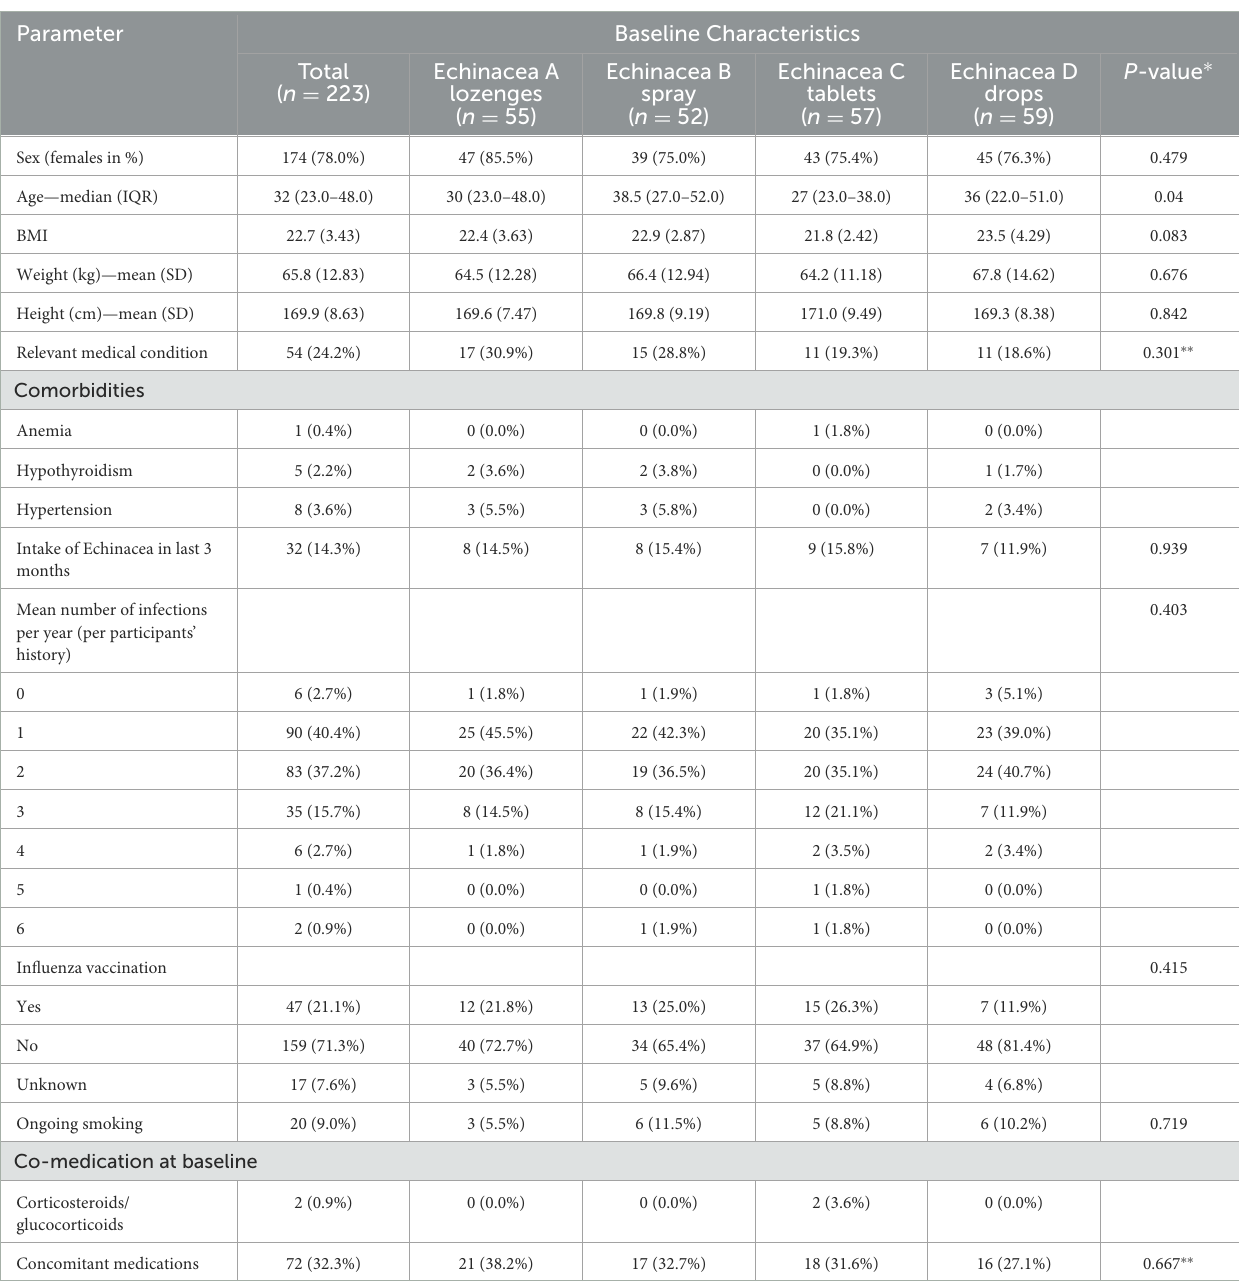
TABLE 3 Baseline